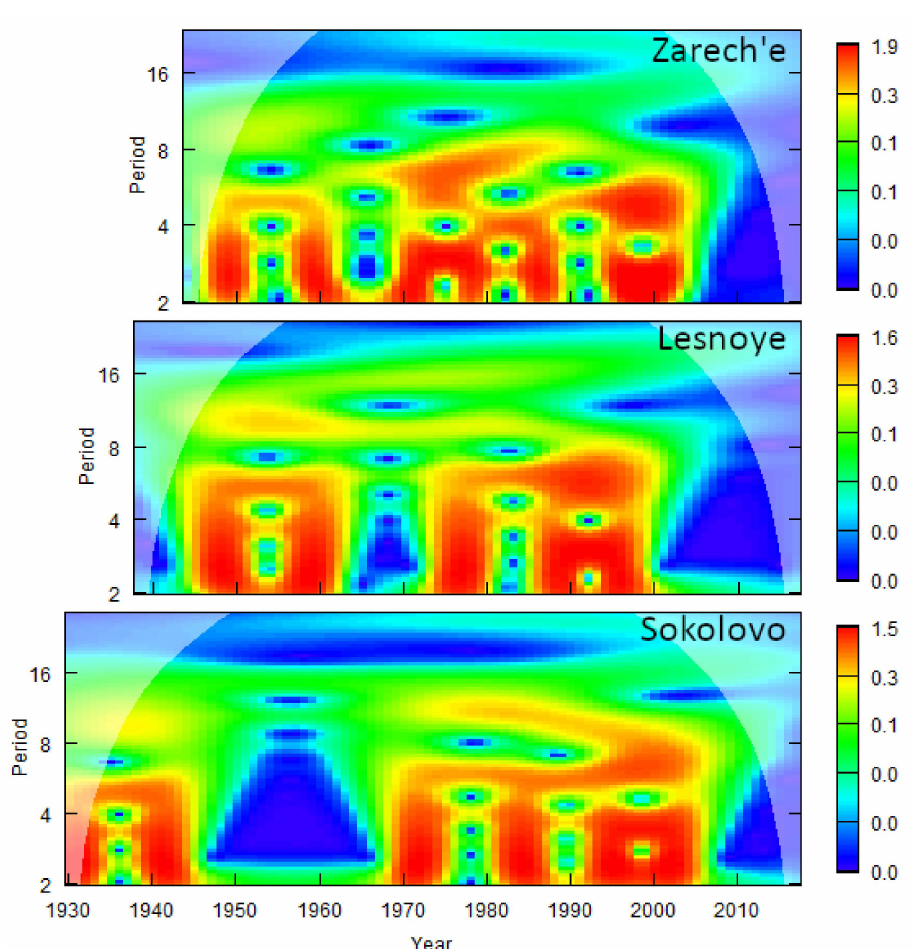
Figure 4. Wavelet analysis of the series of pine looper outbreaks reconstructed from dendrochrono- logical data (for the period with the available weather